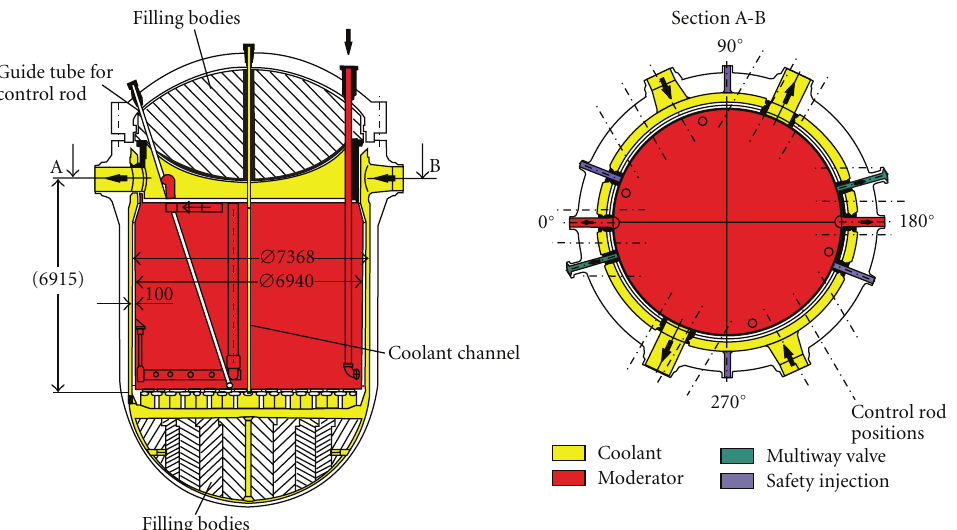
Figure 1: CNA-2 reactor pressure vessel (1 fuel channel and 1 control rod shown only).